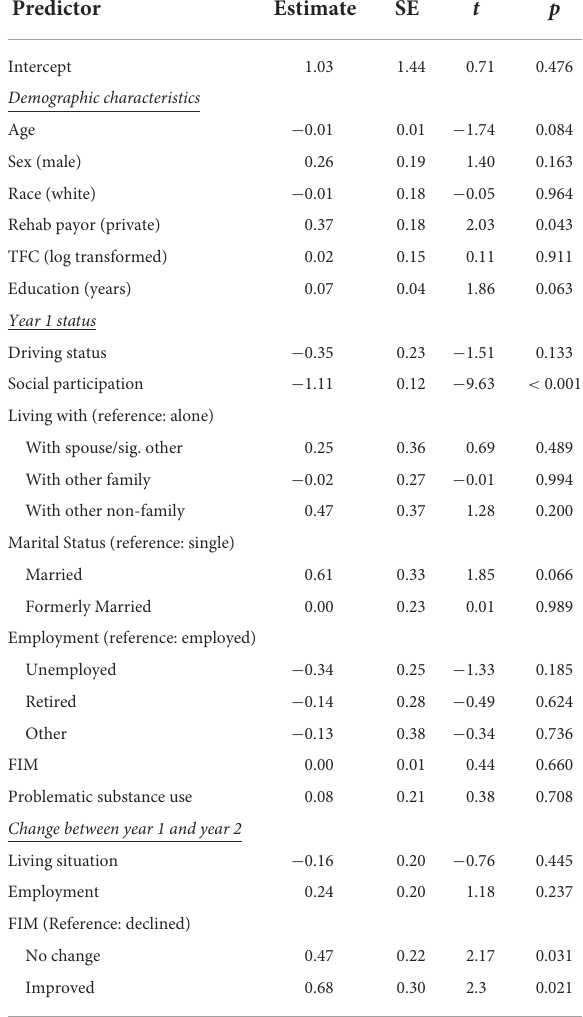
TABLE 3 Linear regression model coefficients for predictors of change in social